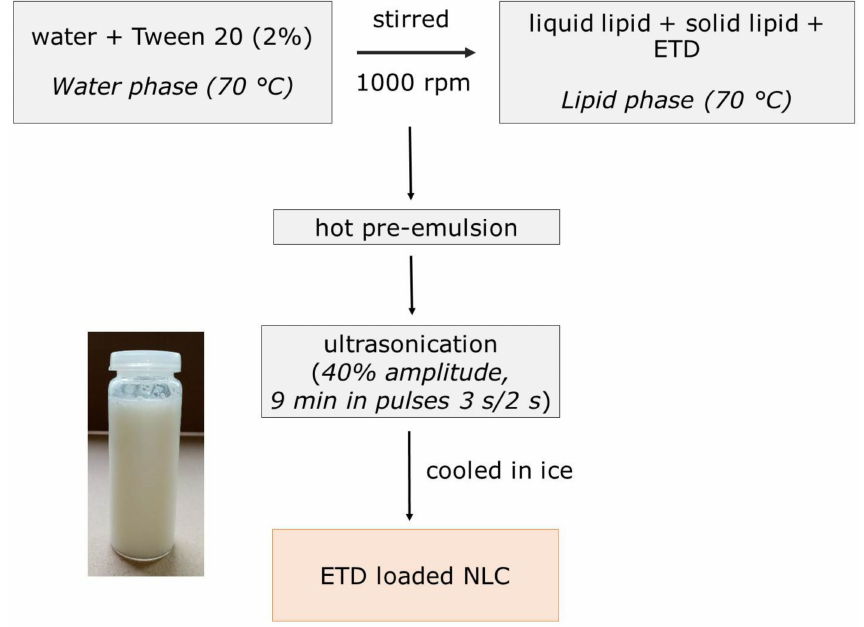
Figure 1. Diagram of nanostructured lipid carriers (NLC) preparation using the melt–emulsification and ultrasonication method and the appearance of etodolac-loaded NLC.